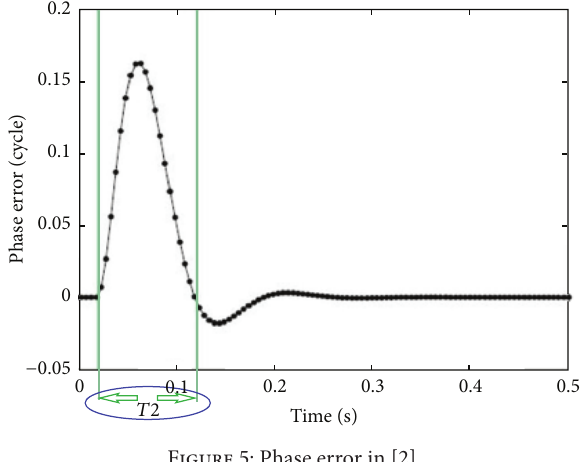
Figure 5: Phase error in [2].